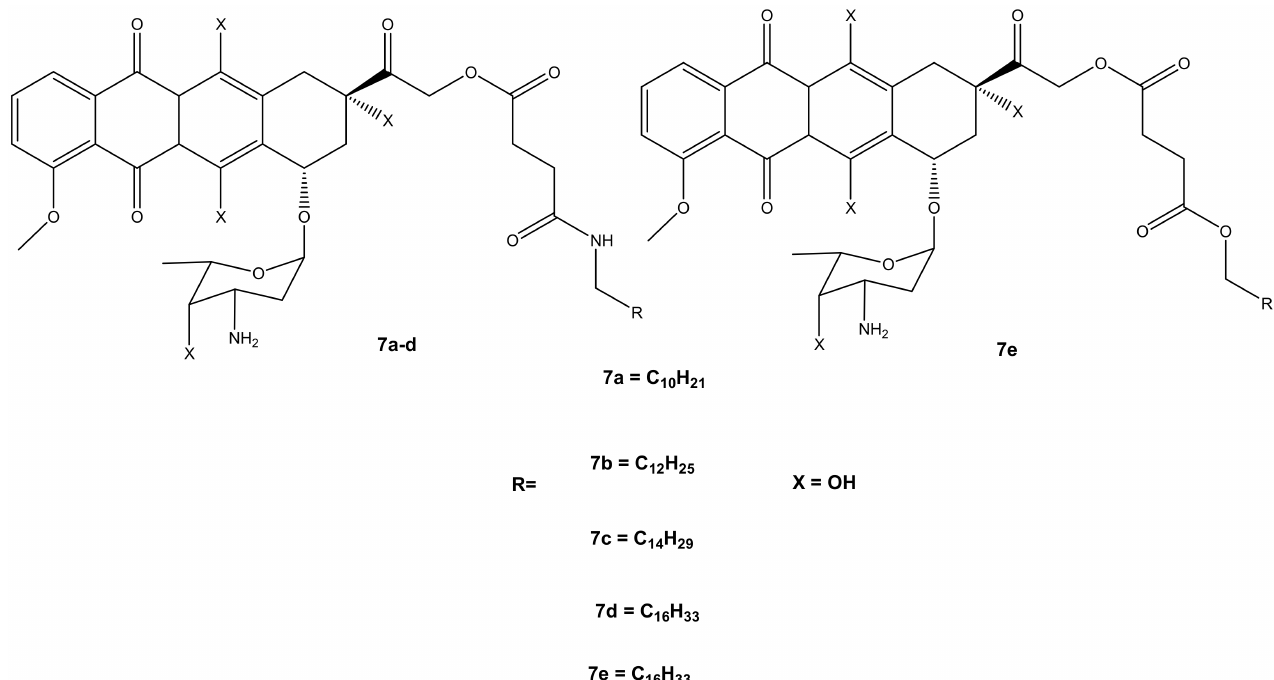
Figure 4. Chemical structures of the second generation of doxorubicin-fatty acyl derivatives synthe- sized via the hydroxyl group in position C-14 ( 7a – e